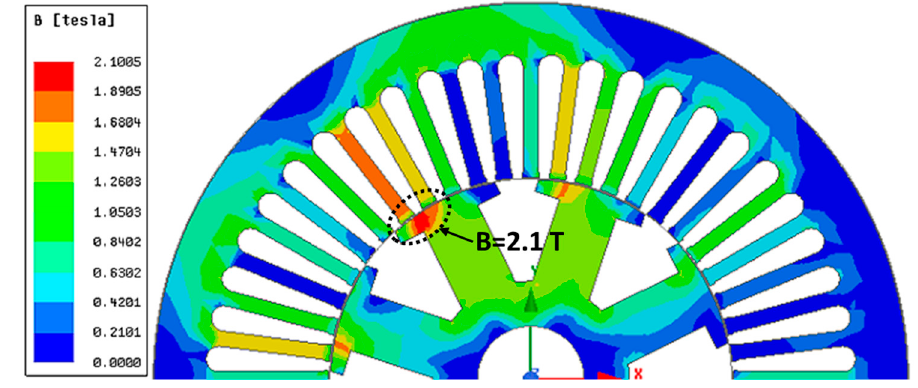
Figure 4. Flux density distribution (basic model).